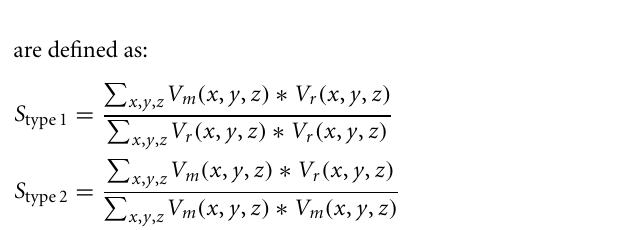
FIGURE 8 | (A) Maximum intensity projection of cerebellar climbing fibers with superimposed reconstruction (A1) and zoomed fragment (A2) . (B) Ground truth (B1) and (B2)